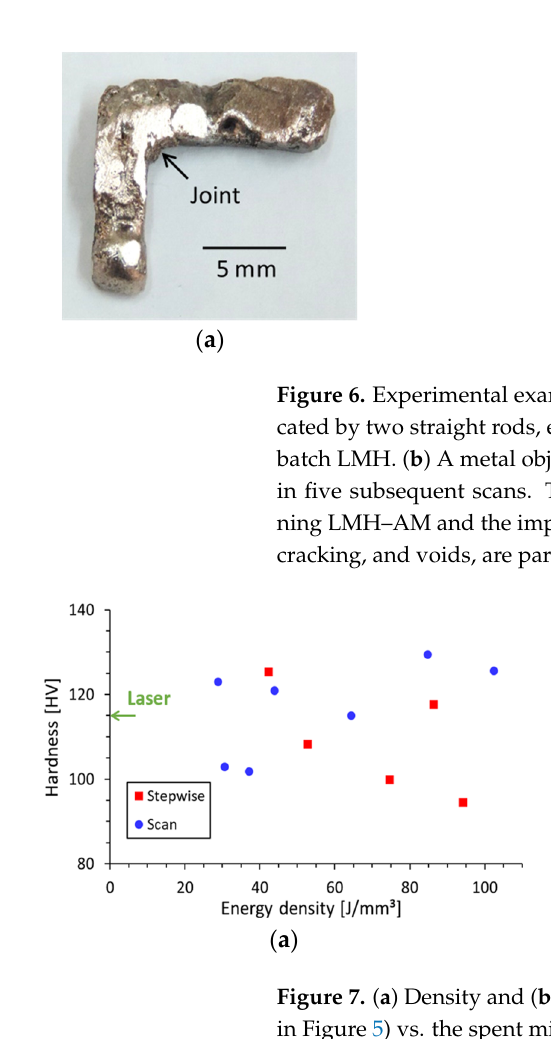
Figure 7. ( a ) Density and ( b ) hardness test results of scanning and stepwise LMH–AM products (as in Figure 5) vs. the spent microwave energy per unit powder volume (i.e., the energy density). The green arrows indicate typical laser-based AM specifications [50], as a benchmark.